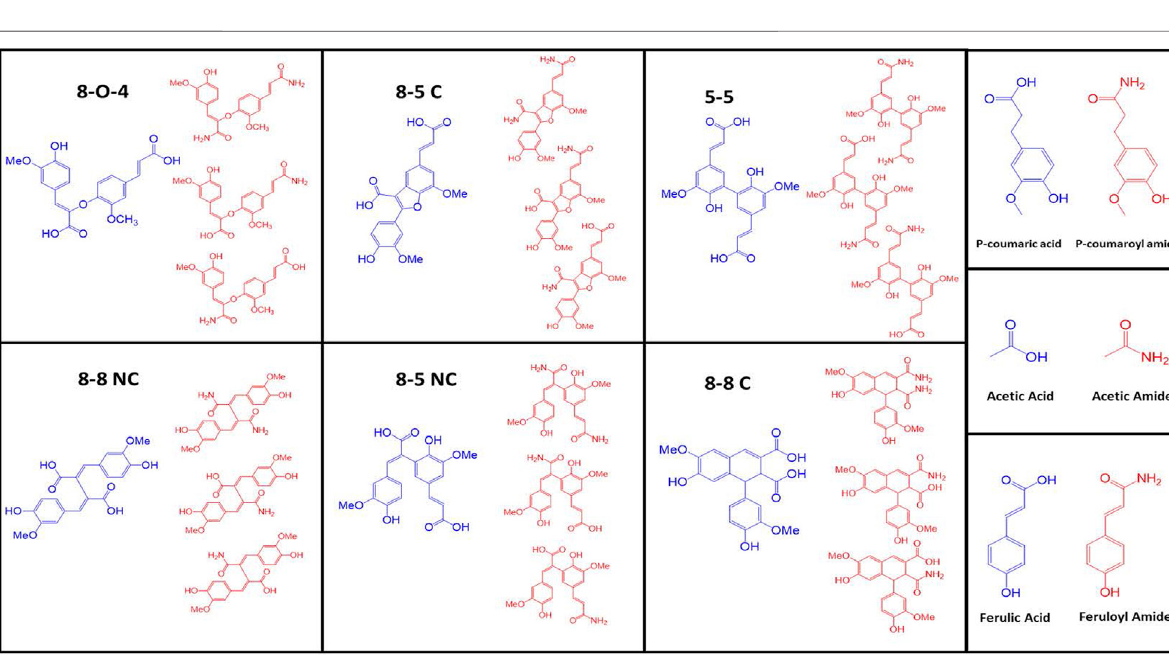
Frontiers in Chemistry |